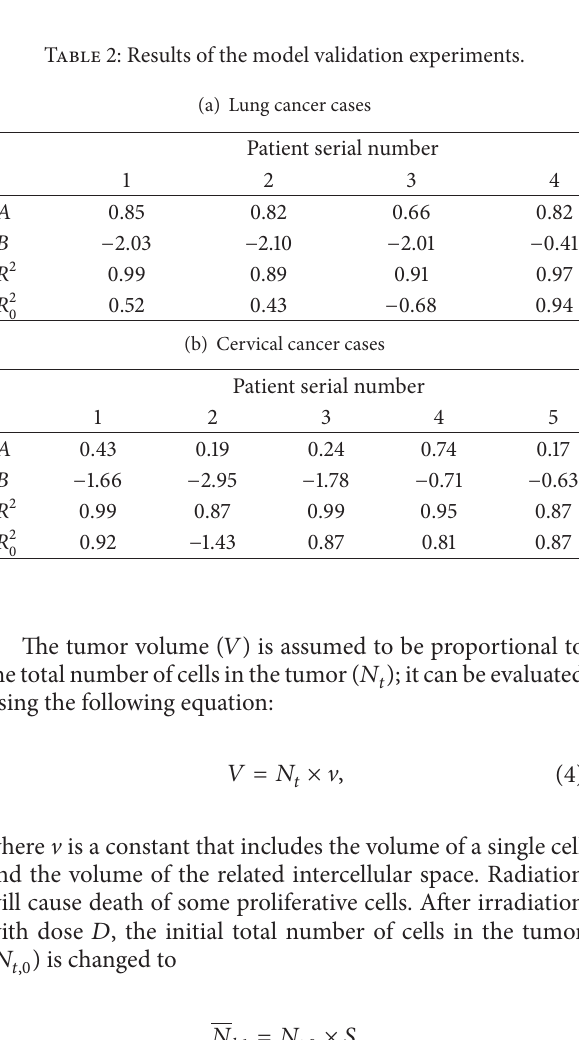
Figure 1: Correlation coefficients of the models: diamonds: 𝑅 2 ; triangles: 𝑅 2 0 ; dash lines: mean values. (a) Lung cancer cases, with mean value of 0.94 for 𝑅 2 and 0.63 for 𝑅 2 0 , respectively; (b) cervical cancer cases, with mean value of 0.93 for 𝑅 2 and 0.87 for 𝑅 2 0 , respectively.